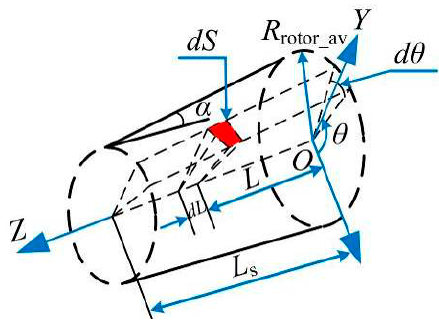
Figure 4. The CR structure and parameters.